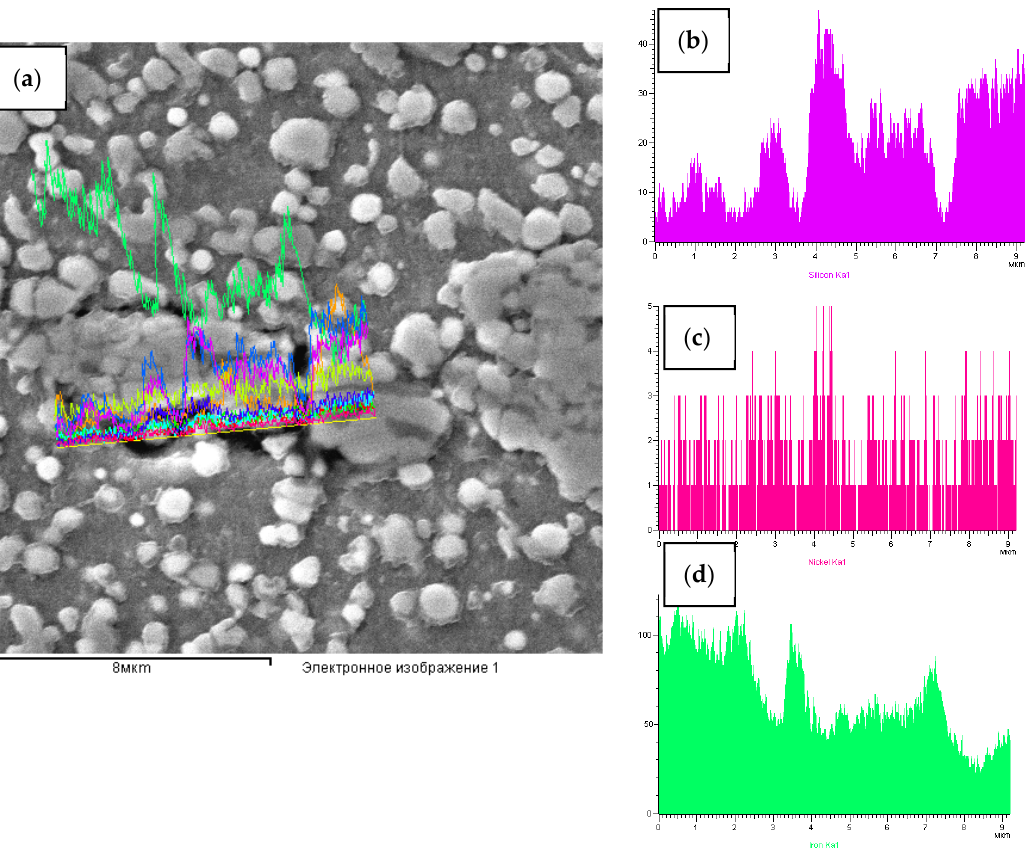
Figure 11. The qualitative analysis of channel element of the structure of W6Mo5Cr4V2 steel after the dynamic alloying in the SDP mode: ( a ) Channel element(fiber) in the structure W6Mo5Cr4V2 steel after the dynamic alloying in the SDP mode; concentration curves of elemental distribution: ( b ) Silicon, ( c ) Nickel and ( d ) Iron. Table 4. The quantitative analysis of channel element of the structure of W6Mo5Cr4V2 steel after the dynamic alloying in the SDP mode with SiC + Ni powder.